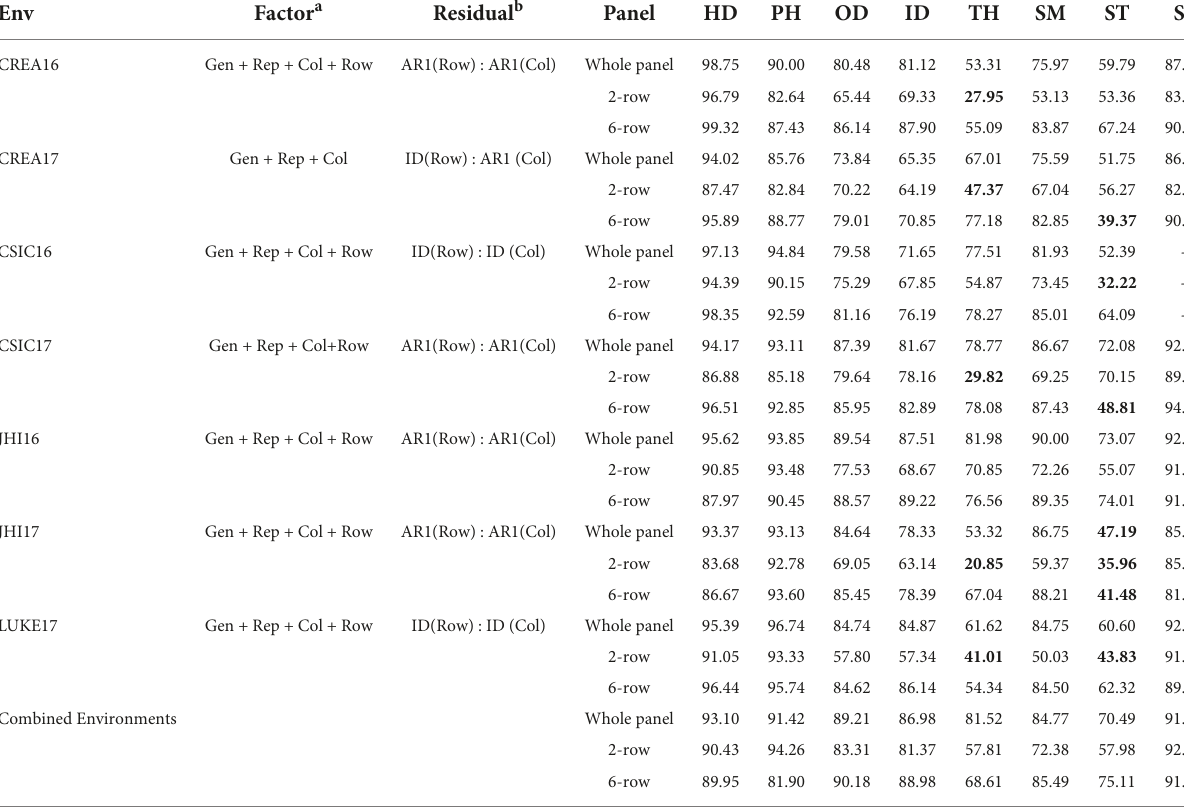
TABLE 1 Estimates of broad-sense heritability for culm morphological traits in single and across